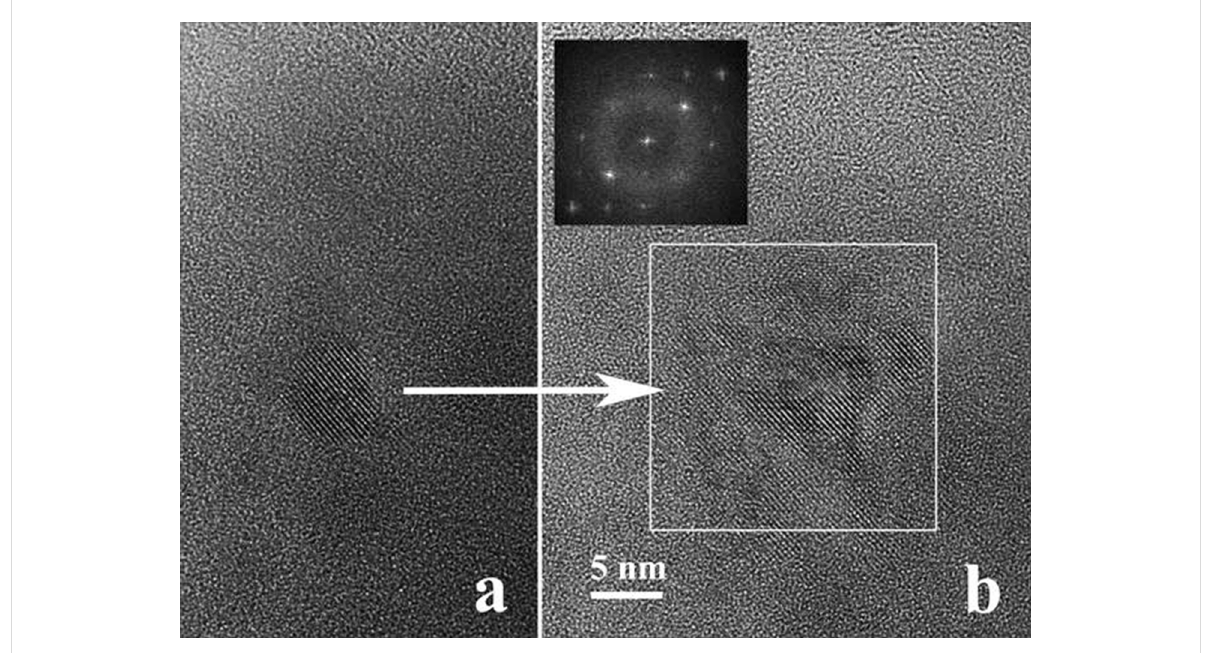
Figure 9: Crystallization (a) and subsequent crystal growth (b) of the Ge amorphous nanoparticle under the high density electron beam irradiation in the microscope. The FFT inserted in the (b) shows a pattern characteristic for the (GeTi)O 2 rutile structure.